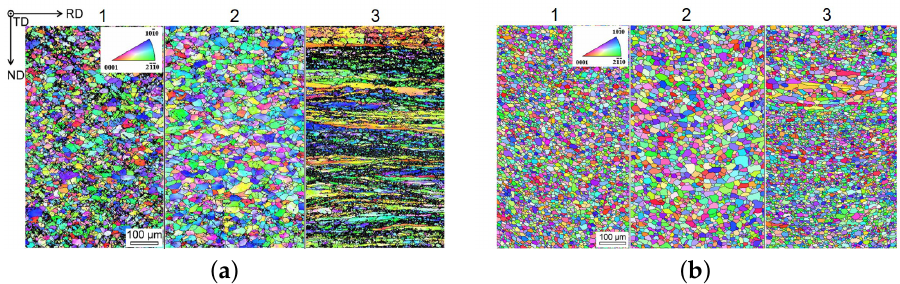
Figure 7. Evolution of microstructure and texture of a Mg-1.2Al-0.3Zn-0.3Ca-0.4Mn alloy, produced by rolling at (1)100 ◦ C with reheating, (2)300 ◦ C with reheating, (3)300 ◦ C without reheating. Reheating took place at 500 ◦ C for 5 min before each rolling pass, and the solution heat treatment was done at 450 ◦ C for1 h [75]. ( a ) As-rolled; ( b ) solution heat treated. Reprinted from Ref. [75] with permission; Copyright Elsevier